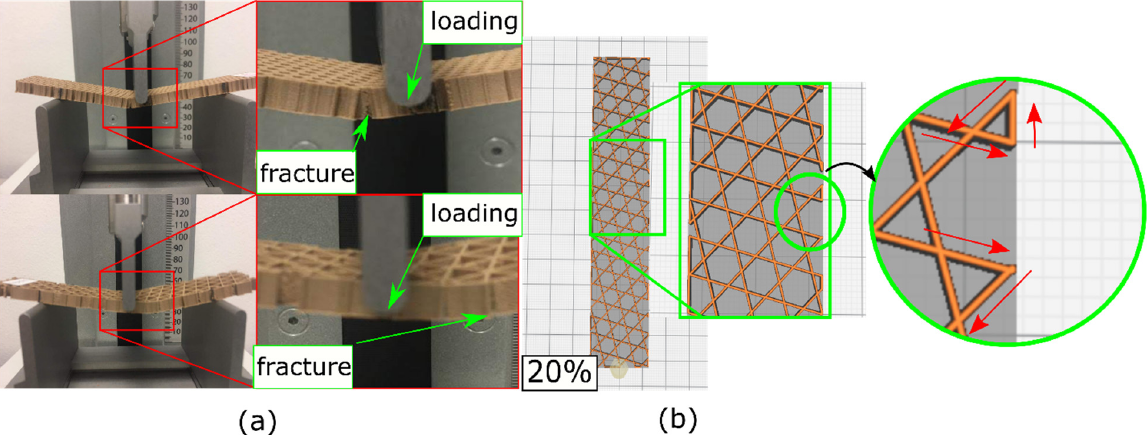
Figure 9. Failure of the lattice PLA-wood samples ( a ); note the failure of being slightly off the loading point, owing to the open zones exposed in ( b ).